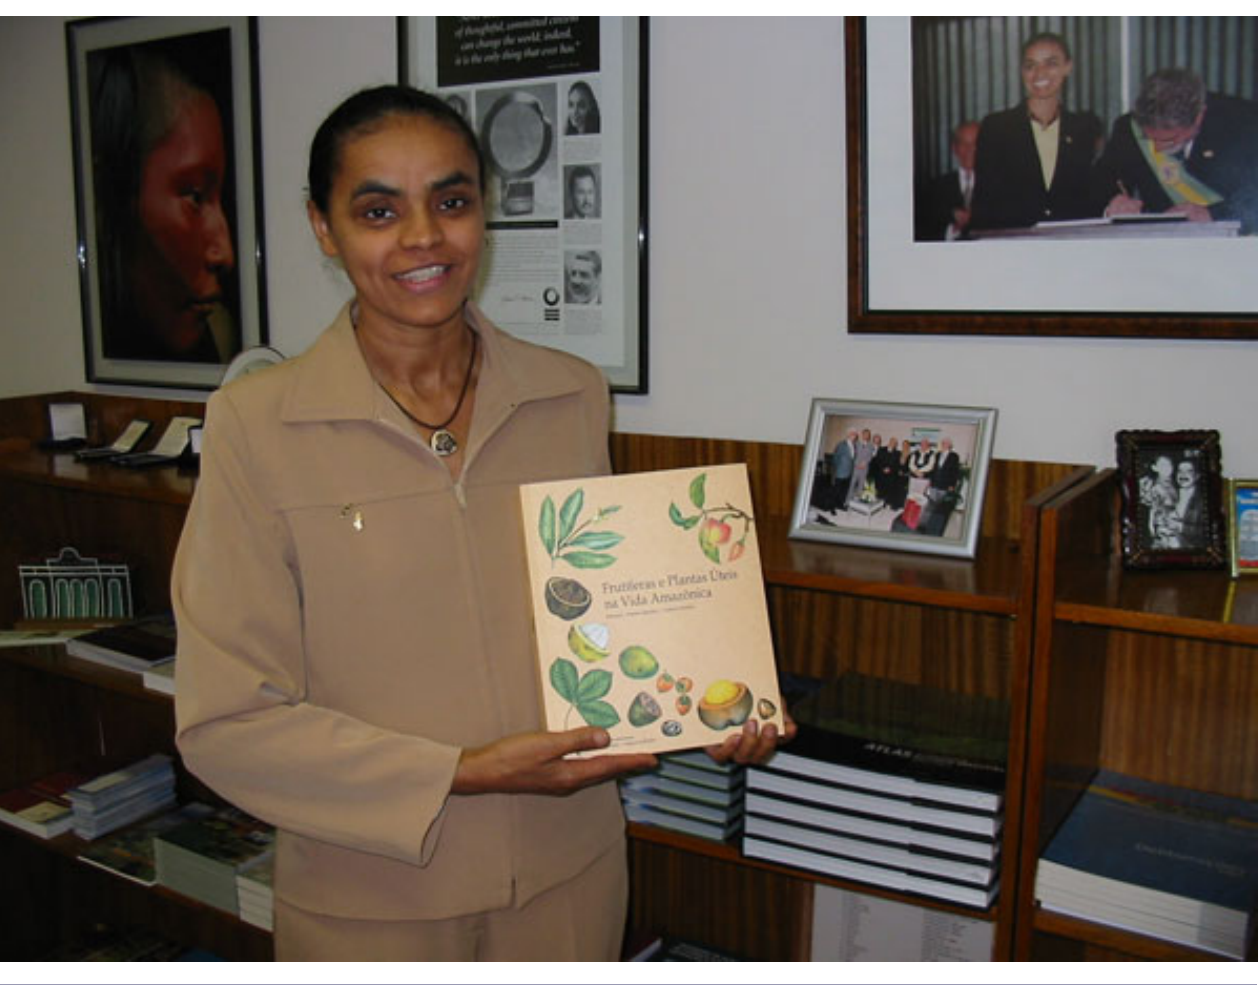
Fig. 13. Brazilian Minister of the Environment Marina Silva celebrates the launching of the Frutíferas book. Photo: Jeferson